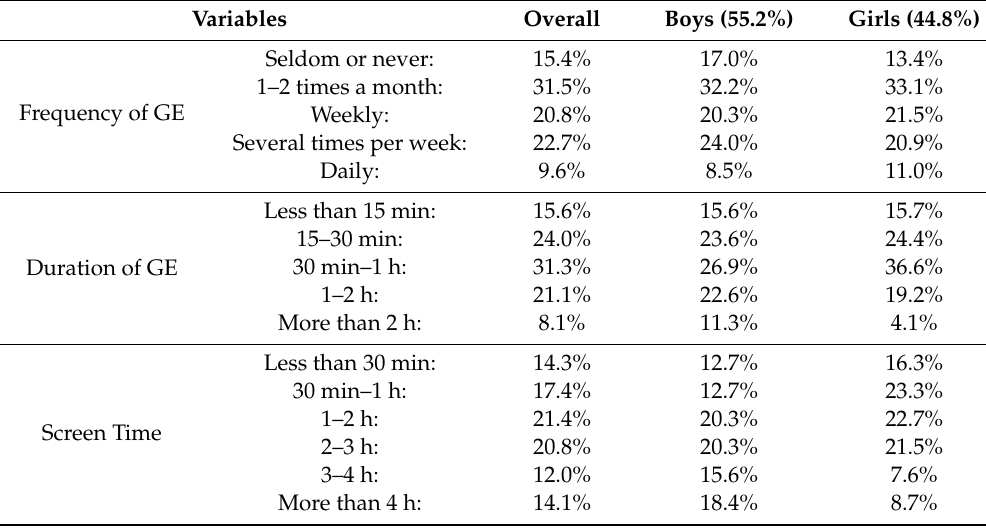
Table 1. The status of adolescents’ green exercise (GE) and screen time ( n = 384). Variables